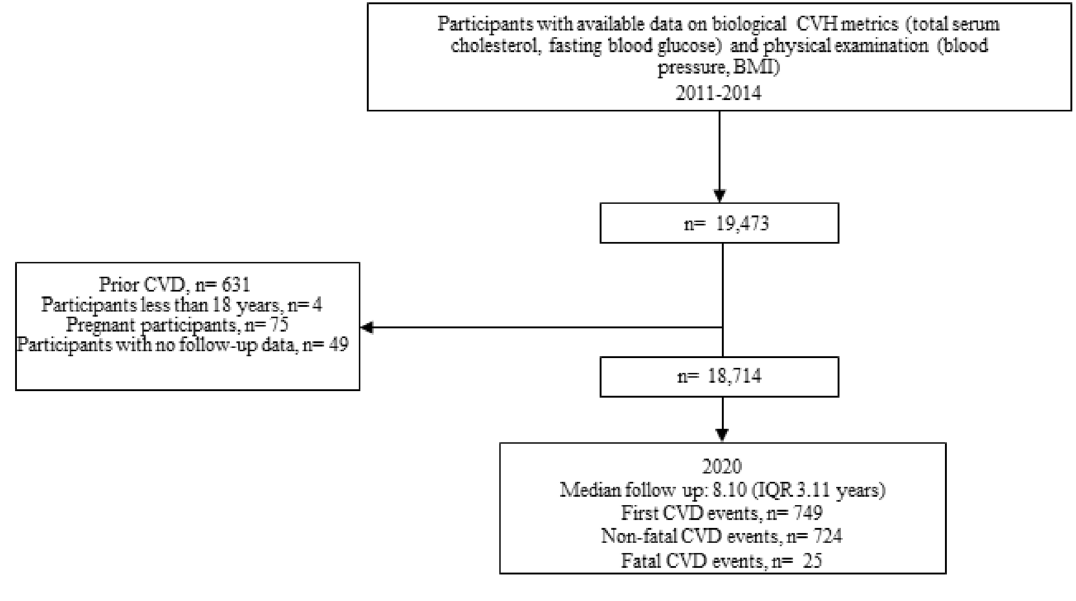
Figure 1. Study sample